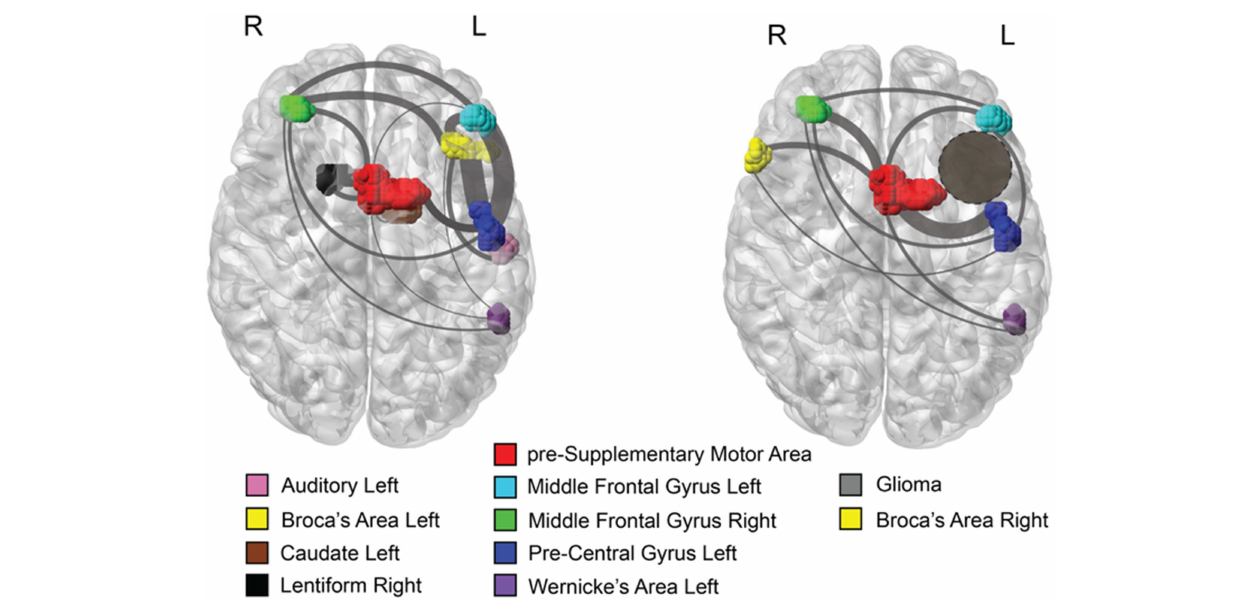
FIGURE 2 | Axial views of the brain with active fMRI areas and links obtained by statistical inference. ( Left ) Brain network topology inferred from a semantic fMRI task for a typical healthy control subject. The primary language areas, BA and WA, are identified in the left hemisphere and are functionally connected. ( Right ) the network consistently found across all the fMRI scans for the patient with left insular glioma. The homolog of the BA on the right hemisphere becomes statistically active and connects with several other active brain areas, implicating a functional reorganization of the brain areas involved in a language task. As opposed to the typical healthy brain, this patient’s right BA does not connect directly with the left WA. Functional communication between these two areas is conveyed through a common area to which they are both linked, the pre-SMA. Gray lines represent functional connectivity, line thickness is proportional to the strength of connectivity, whereas their arrangement is made to facilitate visualization. In both panels, colors indicate different brain regions as reported in the